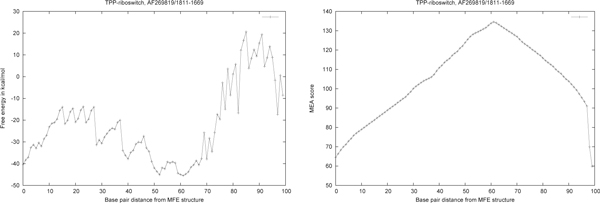
(Left) Free energy for all MEA(k) structural neighbors, 0 ≤ k ≤ 99, of the TPP-riboswitch, AF269819/1811-1669, described in the previous figure. Clearly, MEA(0) and MEA(61) have the least energy, - 46.0 kcal/mol, and MEA(61) has the largest MEA score, 134.555, of all secondary structures for the given RNA sequence. It is more common that the free energy of the MEA(k) structure is monotonically increasing as a function of k. (Right) MEA score for all MEA(k) structural neighbors, 0 ≤ k ≤ 99, of the TPP-riboswitch, AF269819/1811-1669, described in the previous figure. Clearly, MEA(61) has the largest MEA score, 134.555, of all secondary structures for the given RNA sequence.